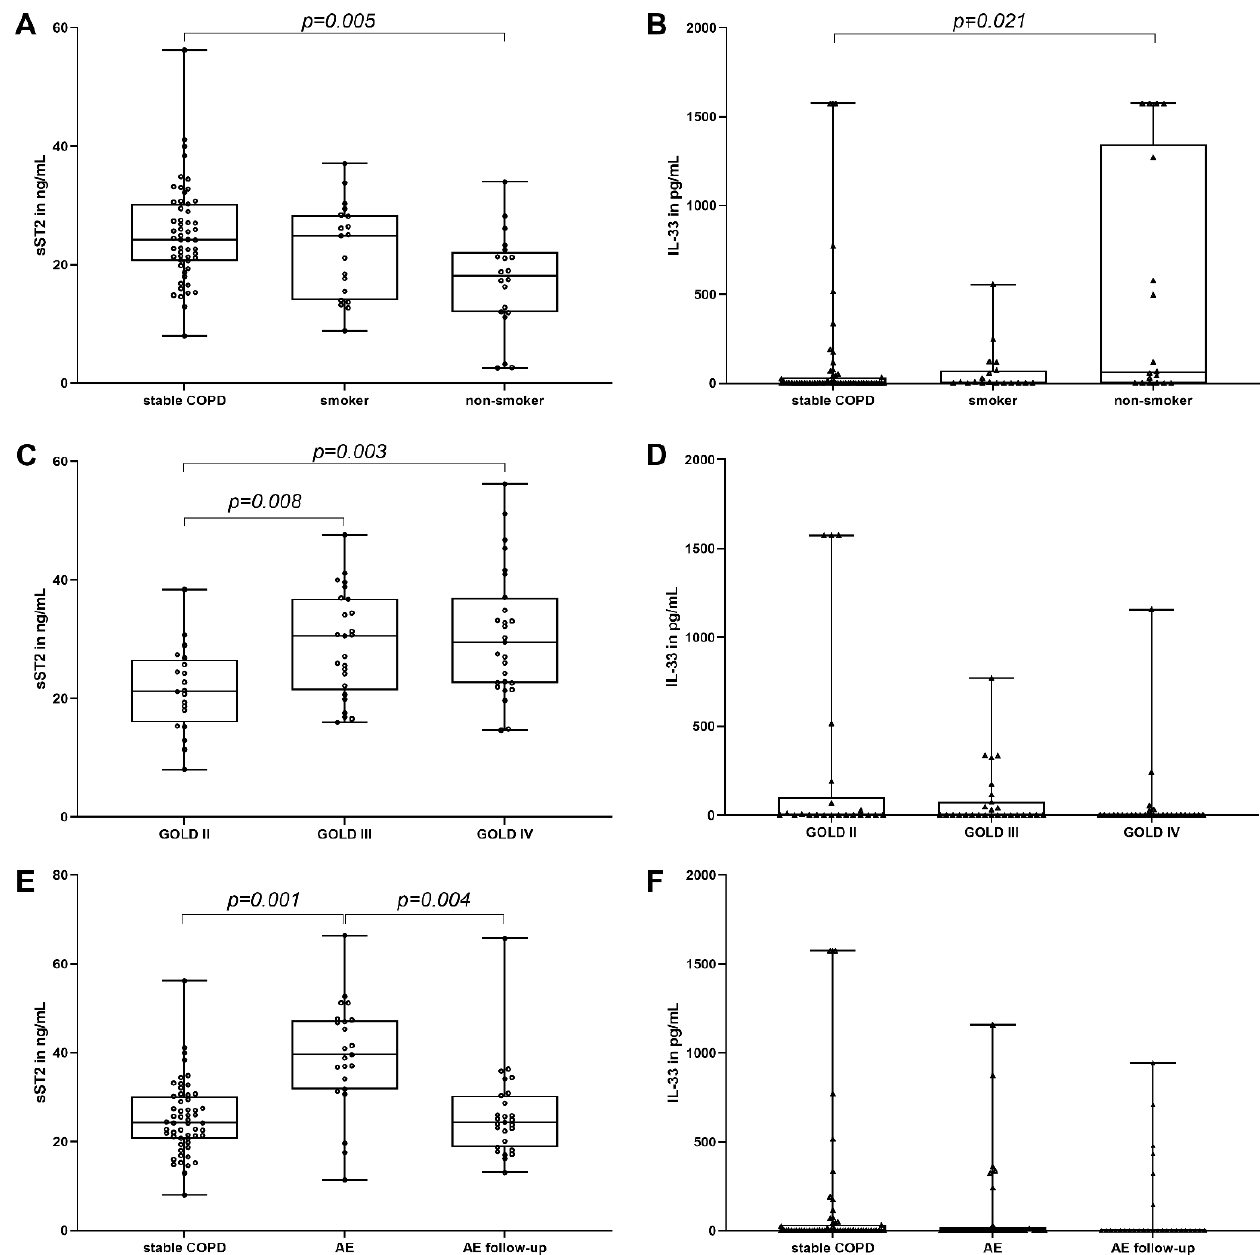
Figure 1. IL-33 and soluble ST2 levels in non-smokers, smokers, patients with stable COPD (panels A and B ), GOLD stage 2–4 (panels C and D ), and exacerbated COPD (panels E and F ). Circulating IL-33 and sST2 were measured as described in the Methods section. Concentrations are depicted as median with interquartile range and given in ng/mL (sST2) and pg/mL (IL-33). Groups were compared using one-way ANOVA as described in Methods section. p -values < 0.05 were considered significant. AE, acute exacerbation.